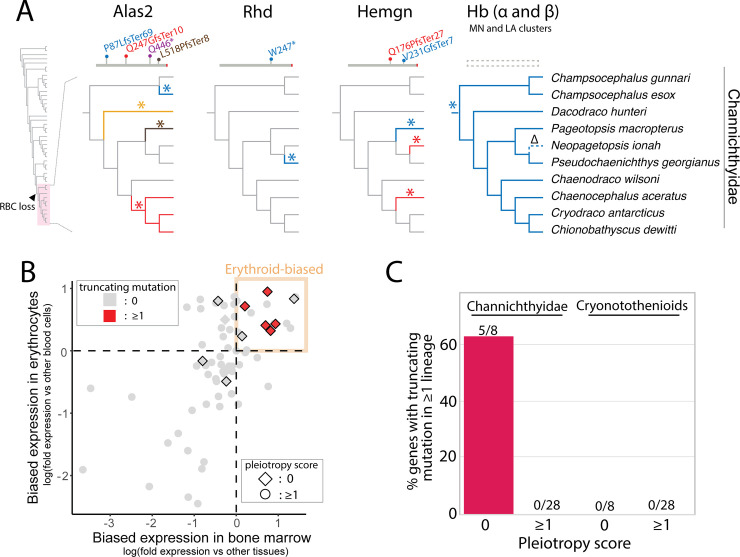
Truncating mutations in erythrocyte-associated genes.(A) Genes with truncating mutations or whole gene deletion in at least one icefish lineage. Asterisks indicate independent mutation events, with color corresponding to the allele above the cladogram. Δ indicates partial deletion of Hb in N. ionah with pseudogenization. See S5–S7 Figs for more detail on the Alas2, RhD and Hemgn mutations. See references 8–10 for analyses of the globin mutations. Arrow in A indicates position of red-blood cell (RBC) loss in icefishes (Channichthyidae) (B) Analysis of pleiotropy in erythroid genes (S4 Table). Genes were sorted by relative expression in mammalian erythrocytes vs other hematopoietic lineages and in mammalian bone marrow vs other organ systems. Genes were assigned a pleiotropy score ≥ 1 if mutations in these genes affect organ systems other than the hematopoietic system in the Mammalian Phenotype Ontology [74]. (C) Percentage of all erythroid-biased genes (S5 Table) with loss-of-function mutations in at least one lineage in icefishes (Channichthyidae) compared to other Antarctic notothenioid (Cryonotothenioids), showing enrichment for loss-of-function mutations in this gene set in species lacking red blood cells.